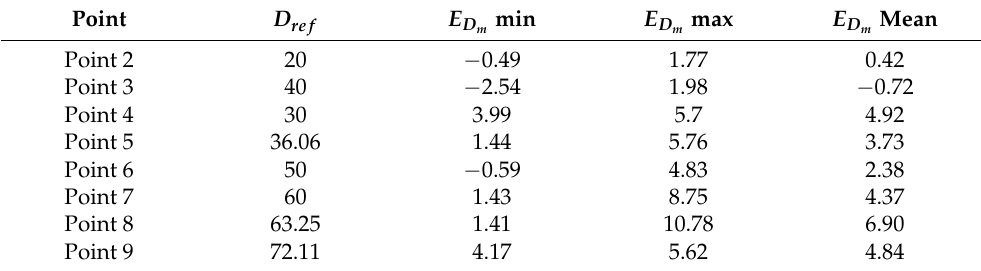
Table 2. Results of the assessment of the human factor error in translation. D ref are the reference distances, while E D is the error in the measured distance of the user’s arrow placement. The m distances are with respect to Point 1 and all values are in